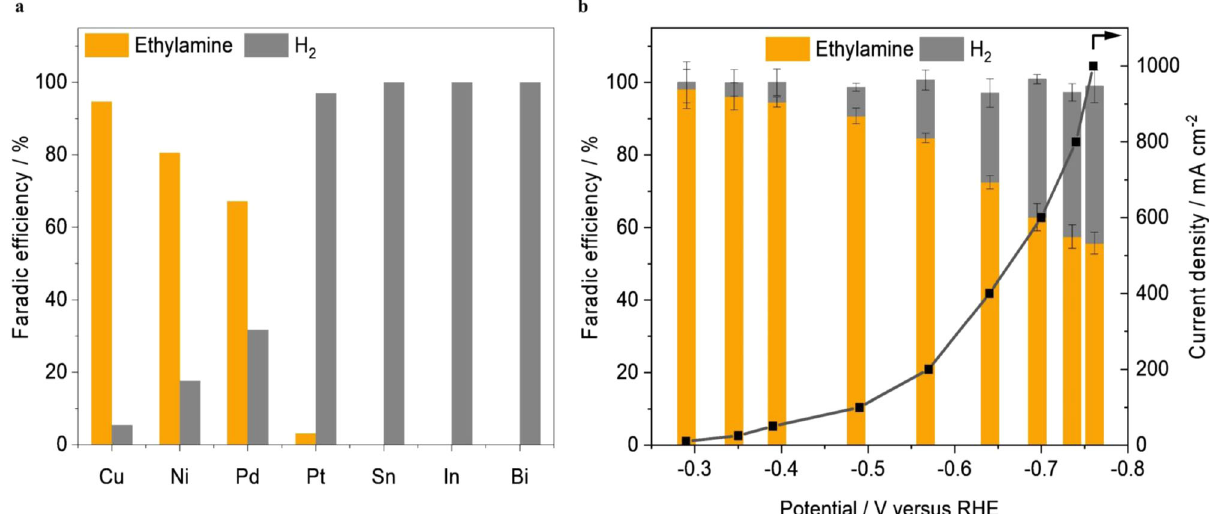
Fig. 2 Comparison of acetonitrile reduction activity on different catalysts. a The highest FE of ethylamine on various metal catalysts and corresponding H 2 FE in the applied potential range of − 0.4 V to − 0.65 V versus RHE. b Ethylamine FE, H 2 FE, and corresponding current density versus applied potentials on Cu nanoparticles in acetonitrile reduction (8 wt% acetonitrile in 1 M NaOH as electrolyte). Error bars represent the standard deviation from at least three independent